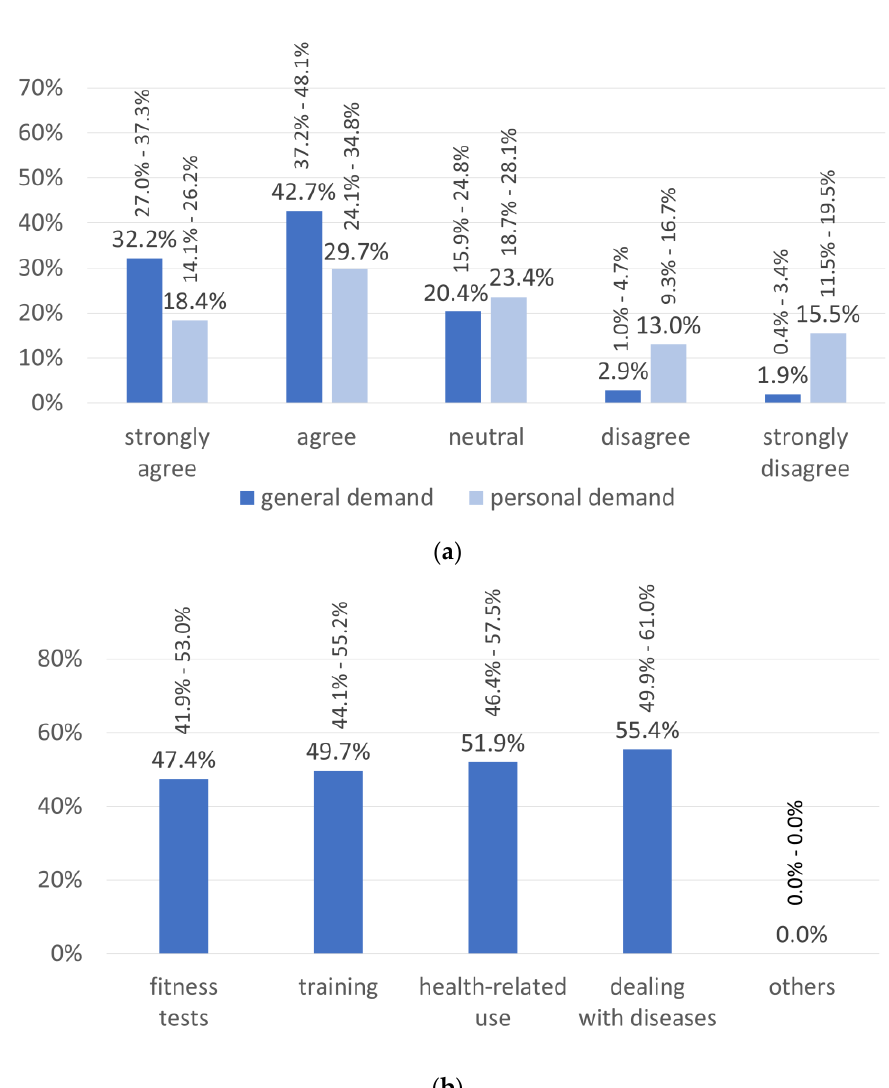
Figure 1. ( a ) Results for the question whether the subjects see a general and/or personal demand for the planned “electronic smart patch system for wireless monitoring of molecular biomarkers for health care and well-being” (ELSAH)-patch system. ( b ) Possible fields of application. Values are expressed as percentages with 95%-CIs.